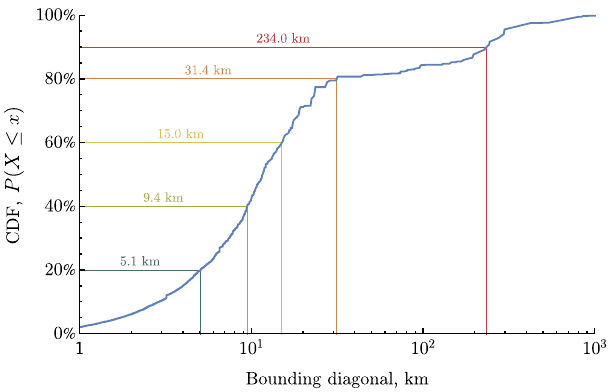
Figure 2. Cumulative distribution function of tweet bounding box sizes. Tweet locations are typically provided in tweet metadata as rectangular bounding boxes, measured by the diagonal length in kilometers. This plot shows the CDF for the number of corresponding tweets as box size increases. For this study, 77% of tweets are retained for further analysis by setting a maximum bounding box diagonal of 25